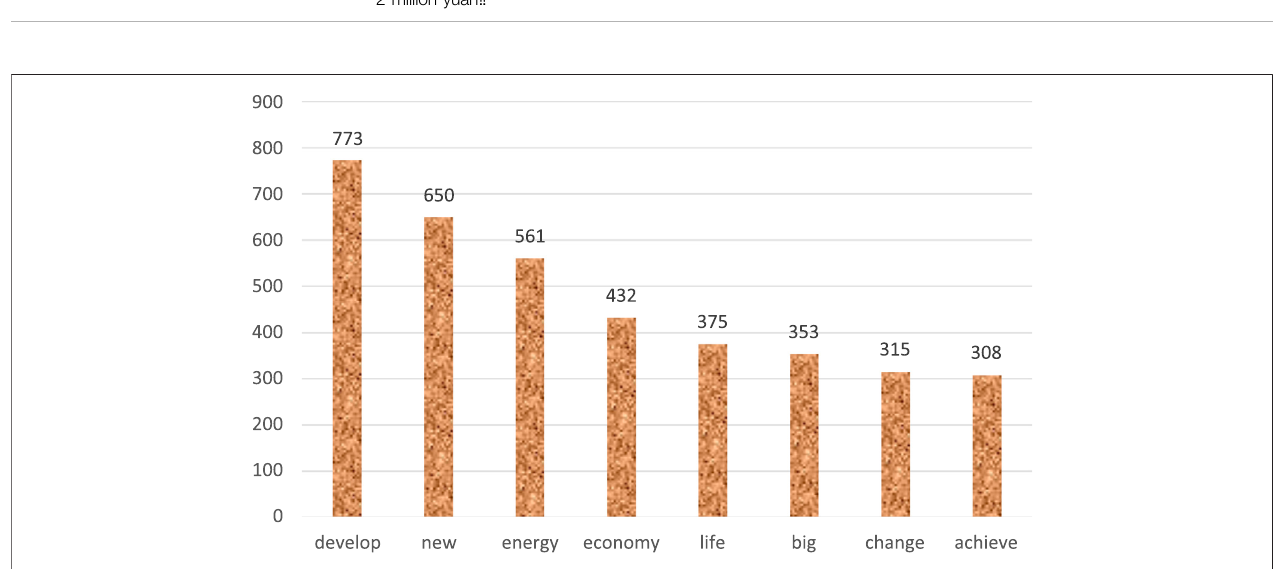
FIGURE 7 | Most mentioned keywords for “ carbon neutral and life change ” in Weibo microposts.